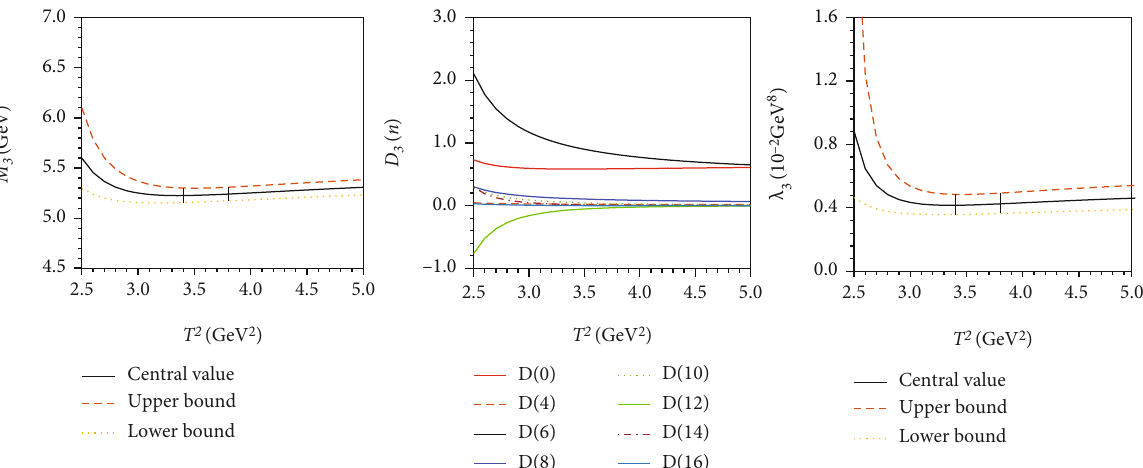
− T 2 for (a), dashed curve is drawn from the upper values of the input parameters and dotted : M 3 3 ð n Þ − T 2 for (b); λ − T 2 for (c), dashed curve is drawn from the upper values of the input parameters 3 3